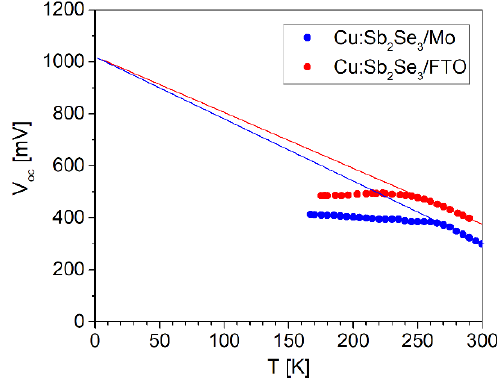
Figure 7. Temperature dependence of V OC for Cu-doped Sb 2 Se 3 tested cells. The extrapolated value of V OC as T → 0 is indicated by the dashed line (≈1.02 V).